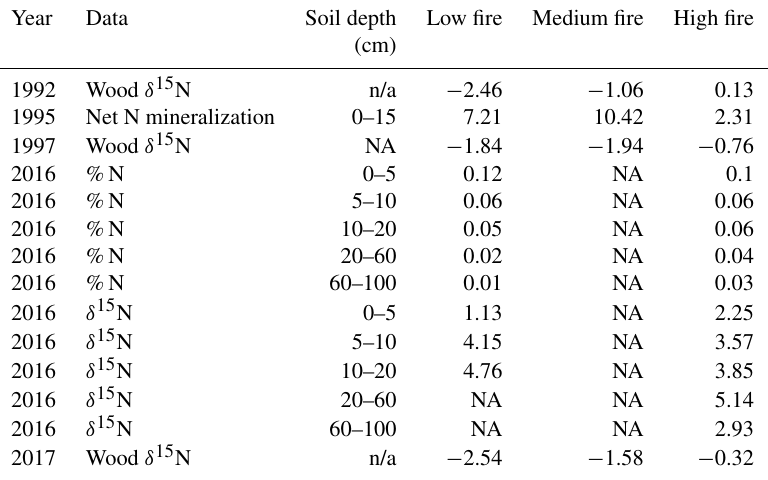
Table 4. Comparison of previously collected soil N data and our wood δ 15 N data from CCESR. Values represent the mean of all samples within each burn unit. Net N mineralization data is sourced from Reich et al. (2001), and soil % N and δ 15 N data are sourced from Pellegrini et al.